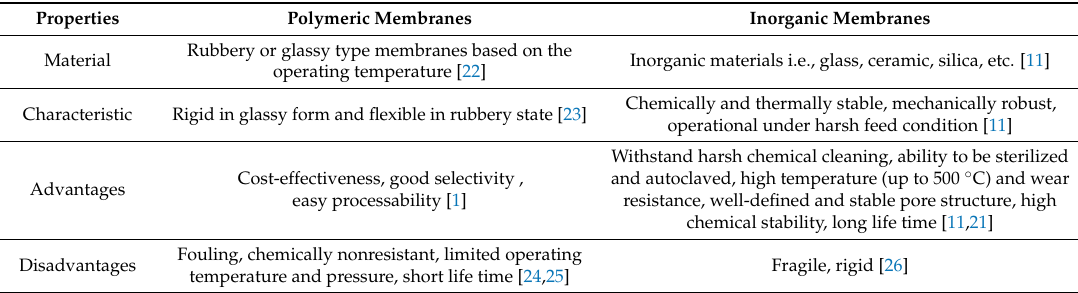
Table 1. Comparison between organic and inorganic